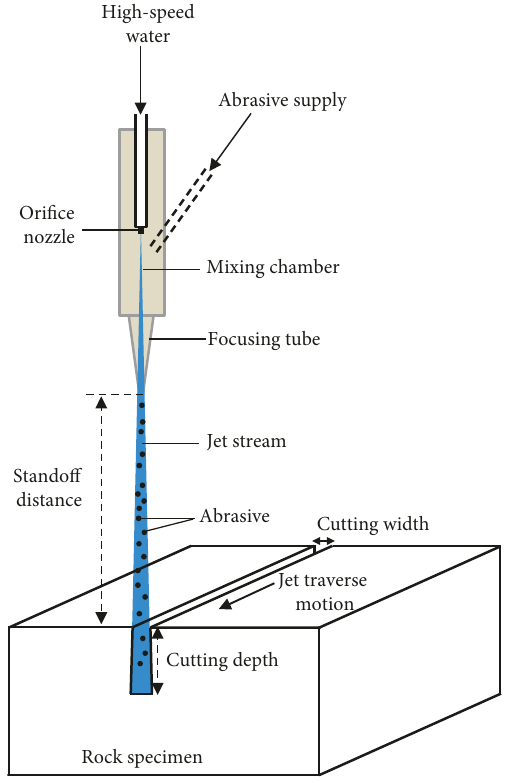
Figure 2: Schematic illustration of rock cutting using an abrasive